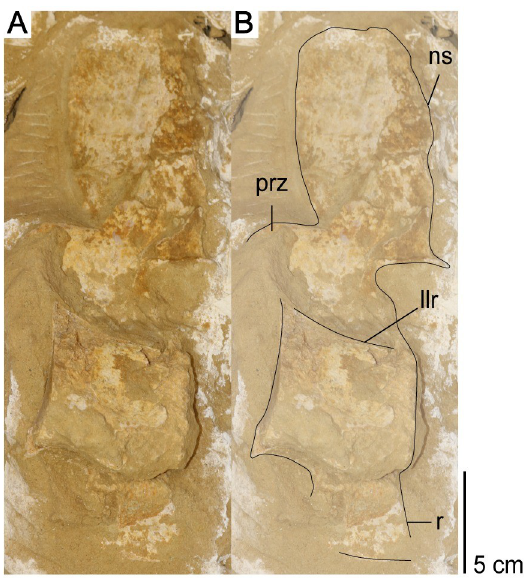
Fig 21. ‘Posterior cervical vertebra a’ in left lateral view from Cardiocorax mukulu (MGUAN PA278). A. Cervical vertebra in left lateral view B. Cervical vertebra with outline and anatomical annotations. posterior projections at the distal end of the ribs. Only ‘anterior cervical vertebra a’ (Fig 19A) exhibits a cervical rib without an anterior projection at the distal end. Rather, the cervical rib of the ‘anterior cervical vertebra a’ is smoothly convex along its anterior margin, concave along the posterior margin, and oriented posterolaterally and ventrally (Fig 19A). The cervical ribs are all single headed without a trace of a suture. Curved ribs extend from the ventrolateral margins of the anterior and middle cervical centra, to where the distal ends are facing ventromedially (Figs 19 and 20). The postzygapophyses of the cervical vertebrae present a smoothly convex ventral surface and extend to the level of the posterior articular facet or slightly more posteriorly. In the anterior cervical vertebrae, the prezygapophyses merge medially to form an inset sur- face. ‘anterior cervical vertebra b’ and ‘anterior cervical vertebra d’ both exhibit a thin ridge of bone that extends from this medial inset surface to the neural spine dorsally (Fig 19B and 19C). This same ridge dividing the prezygapophyses and transitioning to the neural spine was also noted in the anterior cervical vertebrae of Mauisaurus haasti Hector, 1874 [96] by Hiller et al. (2005) [97]. The neural spines from the anterior cervical vertebrae are blade-like (Fig 19). None of the anterior cervical vertebrae present ‘axial striations’ on the lateral and ventral sides of the articular facets, as is present in AMNH 1495 ( Styxosaurus sp.) [7] or Jucha squalea with ridges and furrows on the lateral and ventral surface [12]. The neural spines of the anterior cer- vical vertebrae in MGUAN PA278 are longer than tall, as in most elasmosaurids except Libo- nectes morgani [53] and Lagenanectes richterae [11]. The anterior cervical vertebrae of MGUAN PA278 exhibit neural spines that curve posterodorsally, similar to Aristonectes parvi- dens [70], Elasmosaurus platyurus [65], and Callawayasaurus colombiensis [10], but distinct from Hydrotherosaurus alexandrae [39], Kaiwhekea katiki [66], and Nakonanectes bradti [41] which exhibit anterior cervical neural spines oriented anterodorsally. In the middle cervical vertebrae and posterior cervical vertebra, the dorsal surface of the prezygapophyses form a smooth concave articular facet to receive the postzygapophyses, how- ever, the sharp ridge that extended between the prezygapophyses in the anterior cervical verte- brae is absent in the middle cervical vertebrae (Fig 20). The presence of this ridge in the